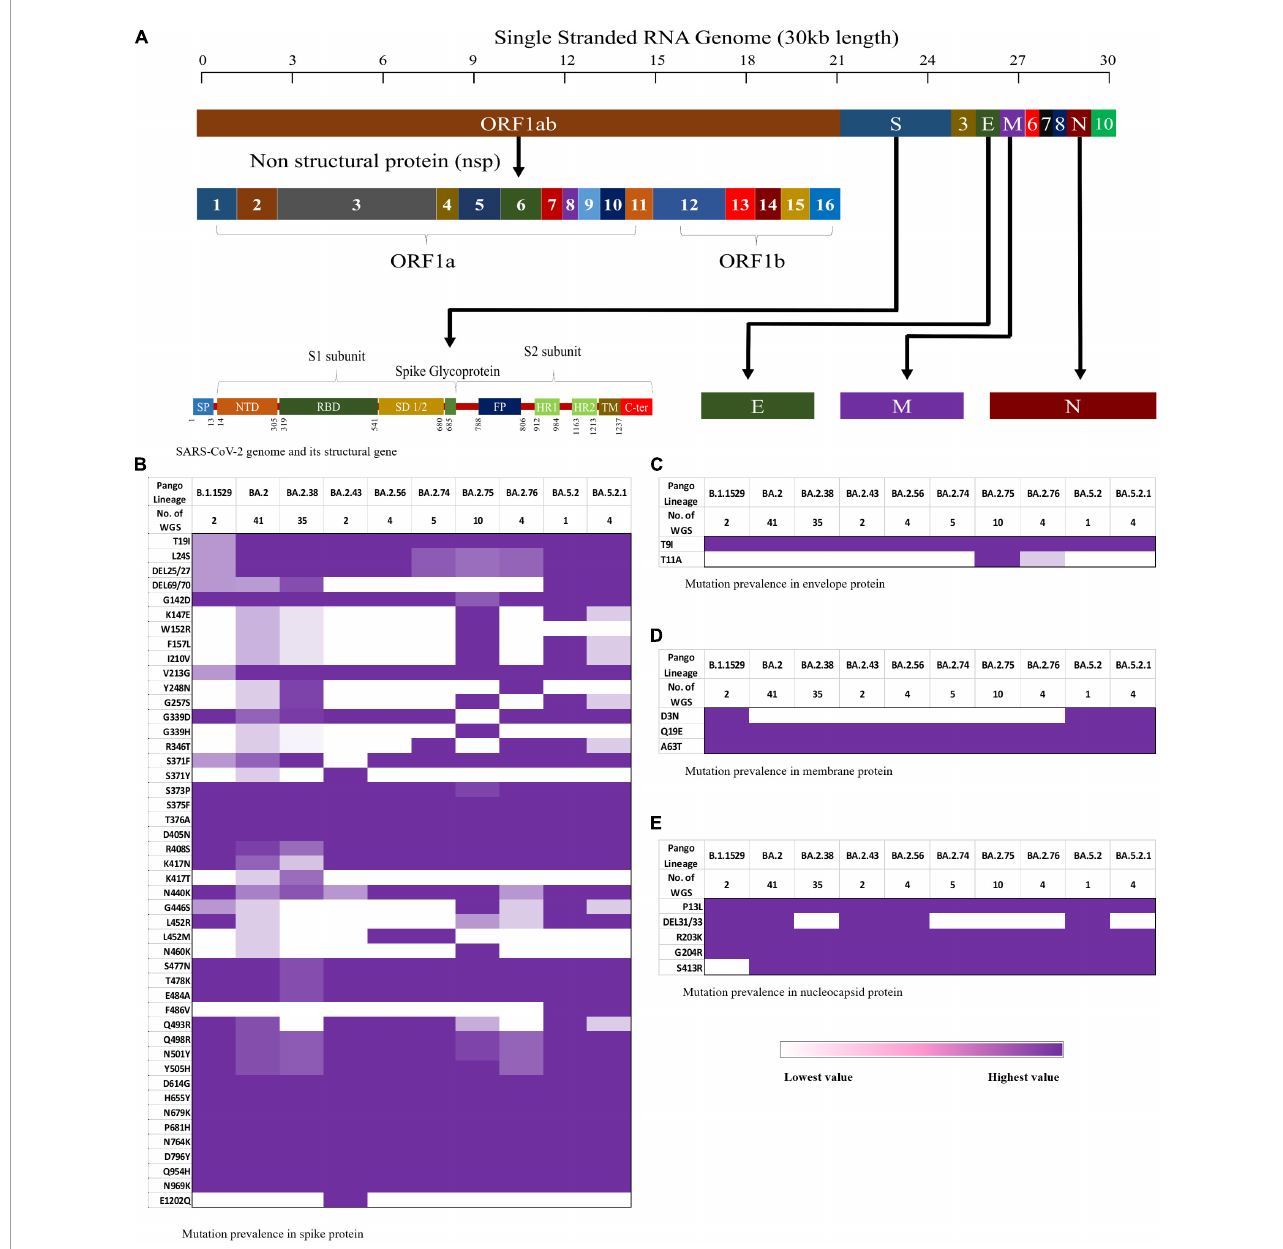
FIGURE3 Schematic representation of the mutation pattern in the four structural proteins is shown as a heat map from lowest (white) to highest (purple). (A) The SARS-CoV-2 genomic arrangement, (B) mutation pattern in spike protein, (C) mutation pattern in envelop protein, (D) mutation pattern in membrane protein, and (E) mutation pattern in nucleocapsid